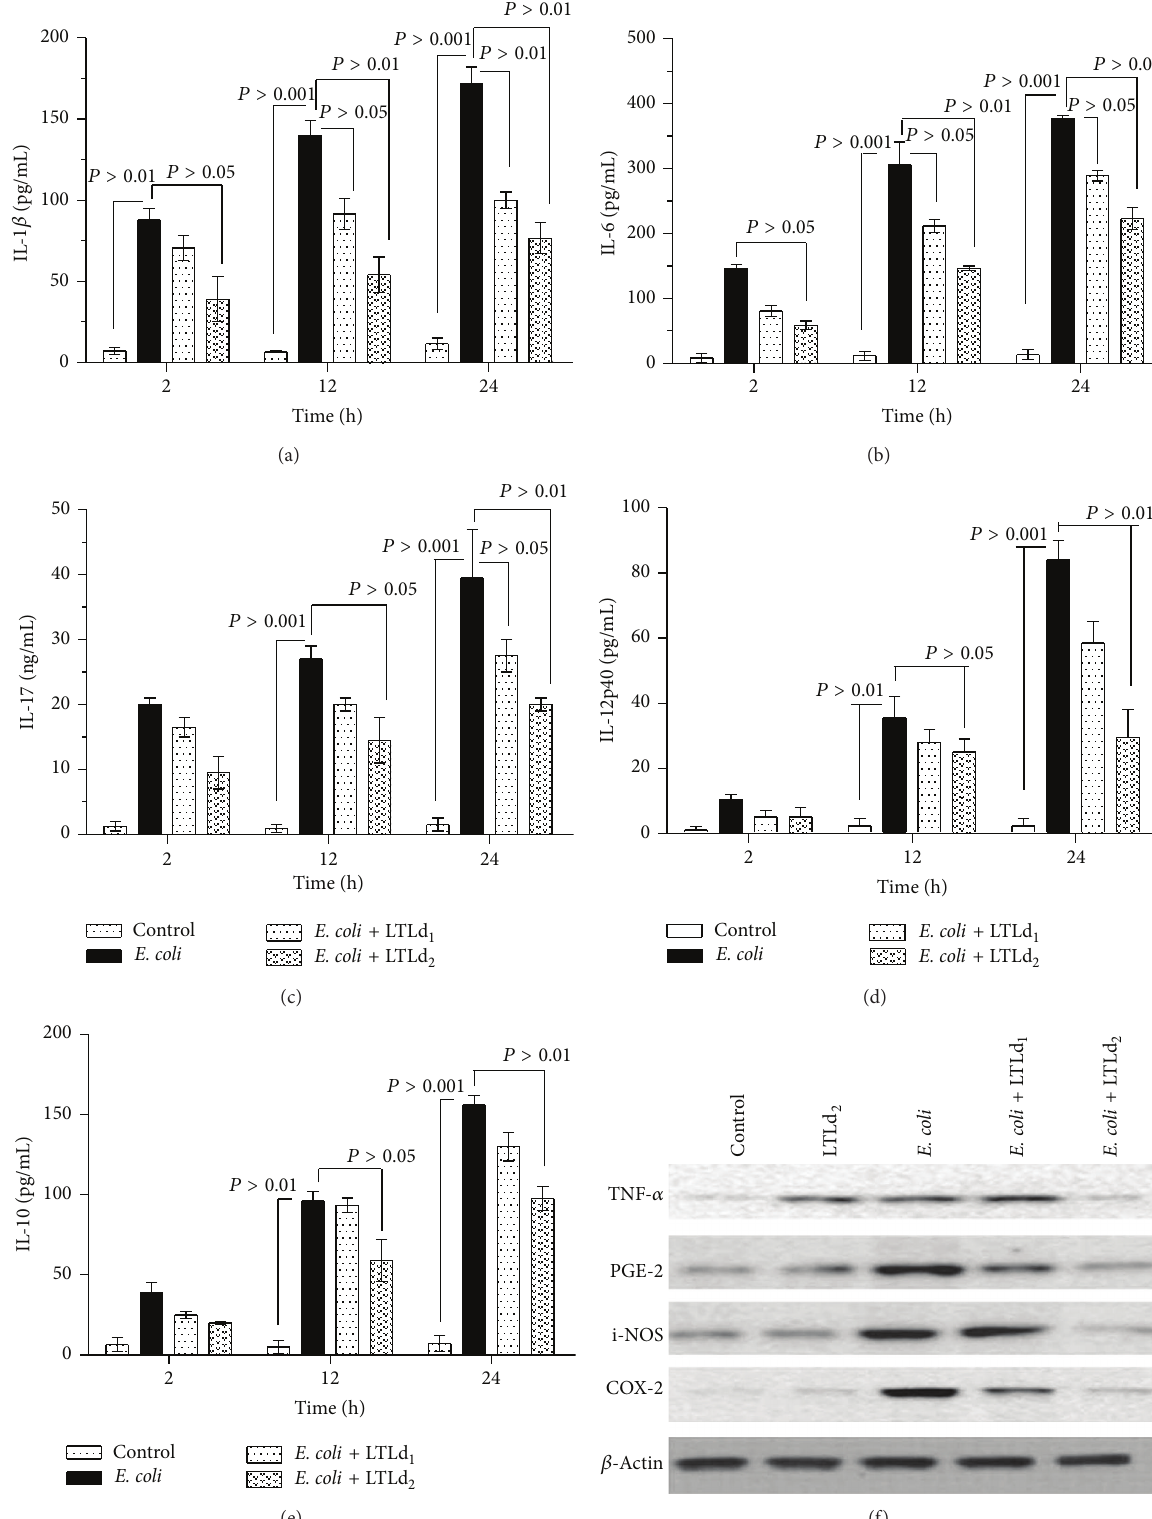
Figure 2: After 12 h incubation of LTL in E. coli induced peritoneal macrophage cells with heat-killed E. coli (O18:K1; 1×10 8 CFU/mL) alone or with LTLd 1 (50 𝜇 g/mL) or LTLd 2 (100 𝜇 g/mL), effect on production of cytokines IL-1 𝛽 (a), IL-6 (b), IL-17 (c), IL-12 (d), and IL-10 (e) was measured by ELISA at 2, 12, and 24h and (f) the inflammatory mediator expression level was determined by western blot analysis. The values are mean ± SEM of three independent experiments. ( ∗ 𝑃 < 0.05 , ∗∗ 𝑃 < 0.01